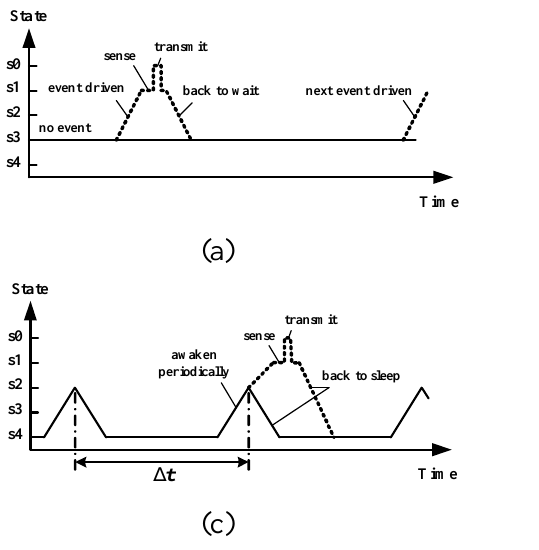
Figure 1. Comparison of awakening mechanisms: (a) Event-driven on s ; (c) Awakening periodically to s periodically to s 1